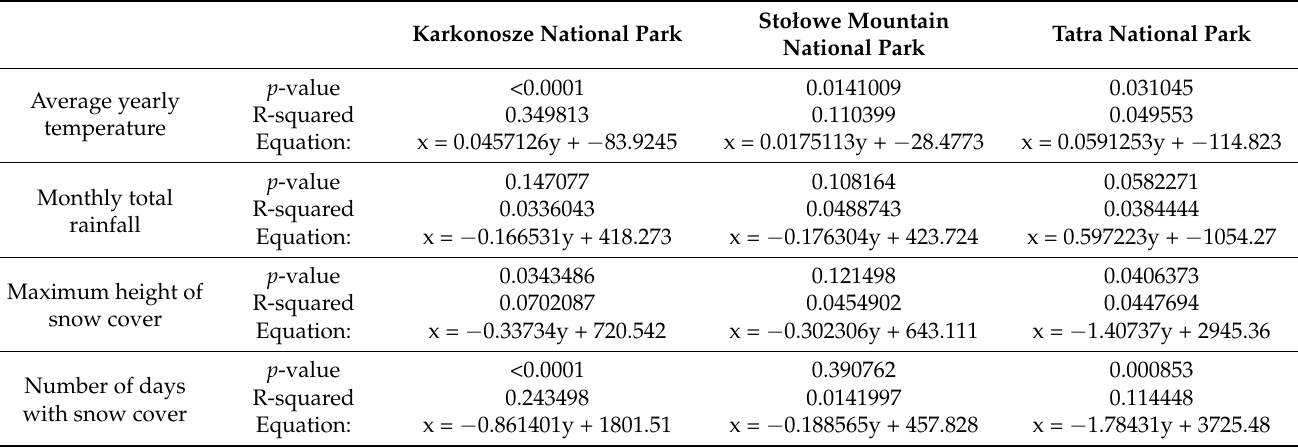
Table 4. Lineal regression